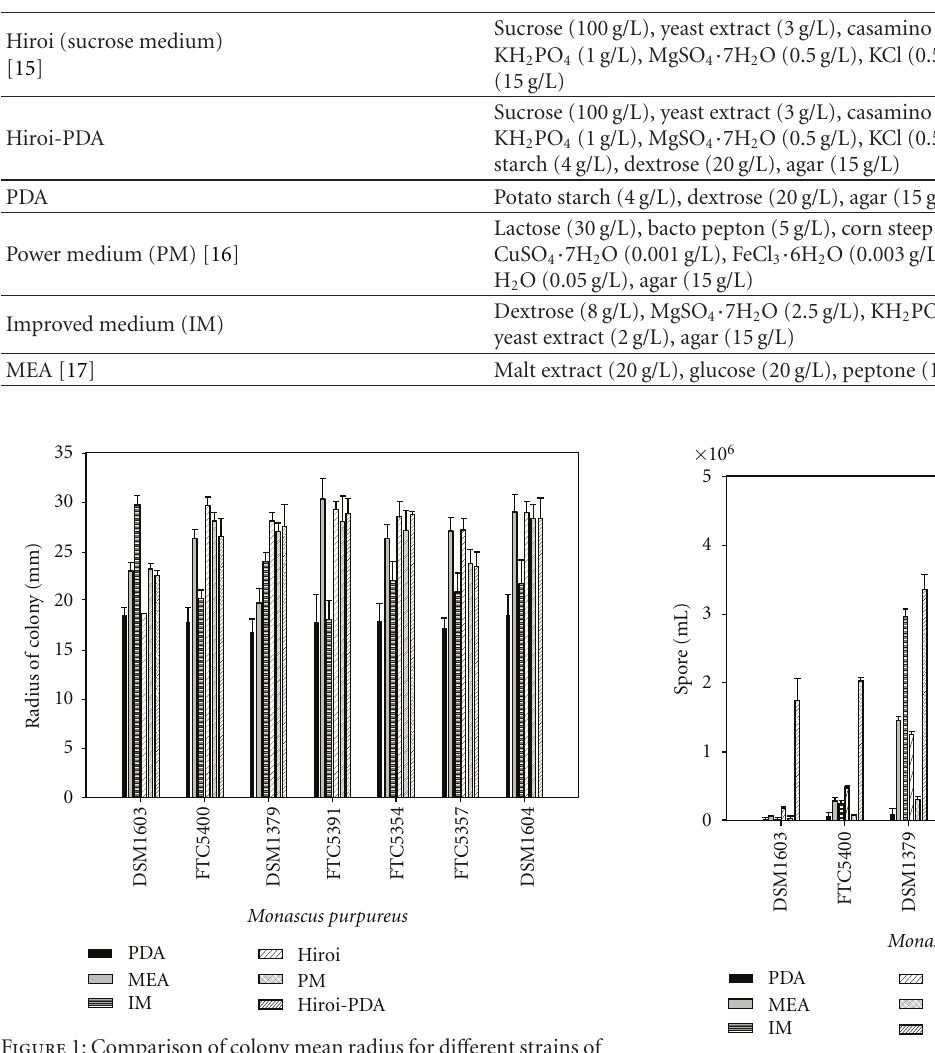
Figure 2: Comparison of sporulation among di ff erent strains of Monascus spp cultivated on di ff erent solid media. Data are average of three determinations (mean ±